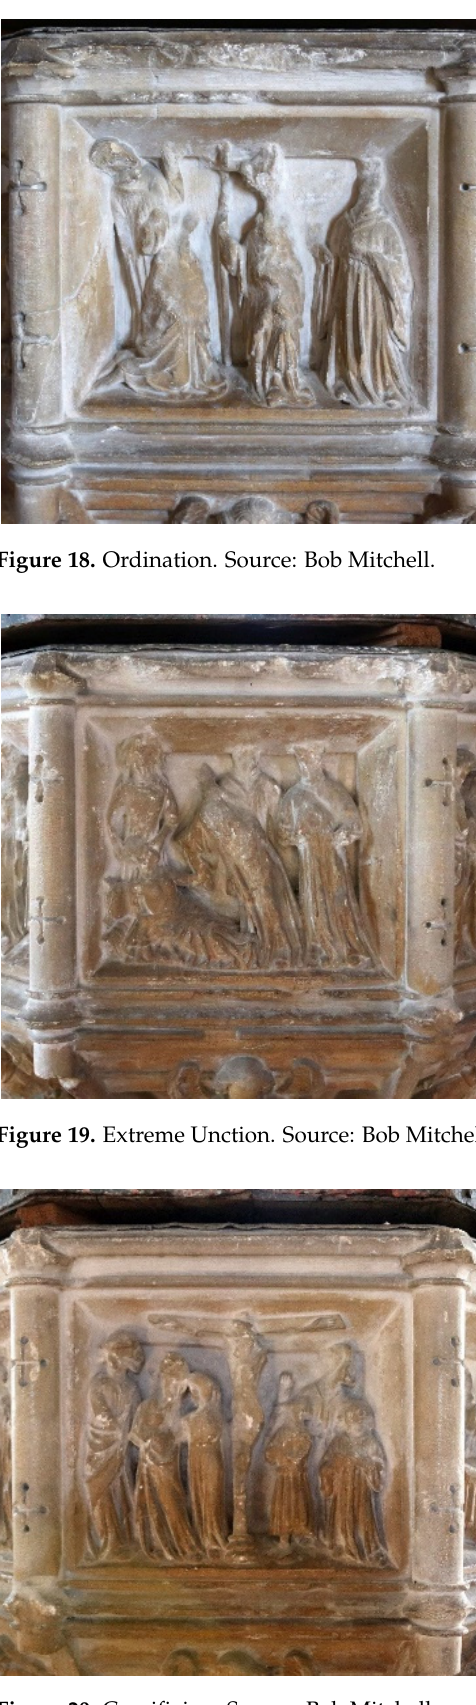
Figure 17. Matrimony. Source: Bob Mitchell.